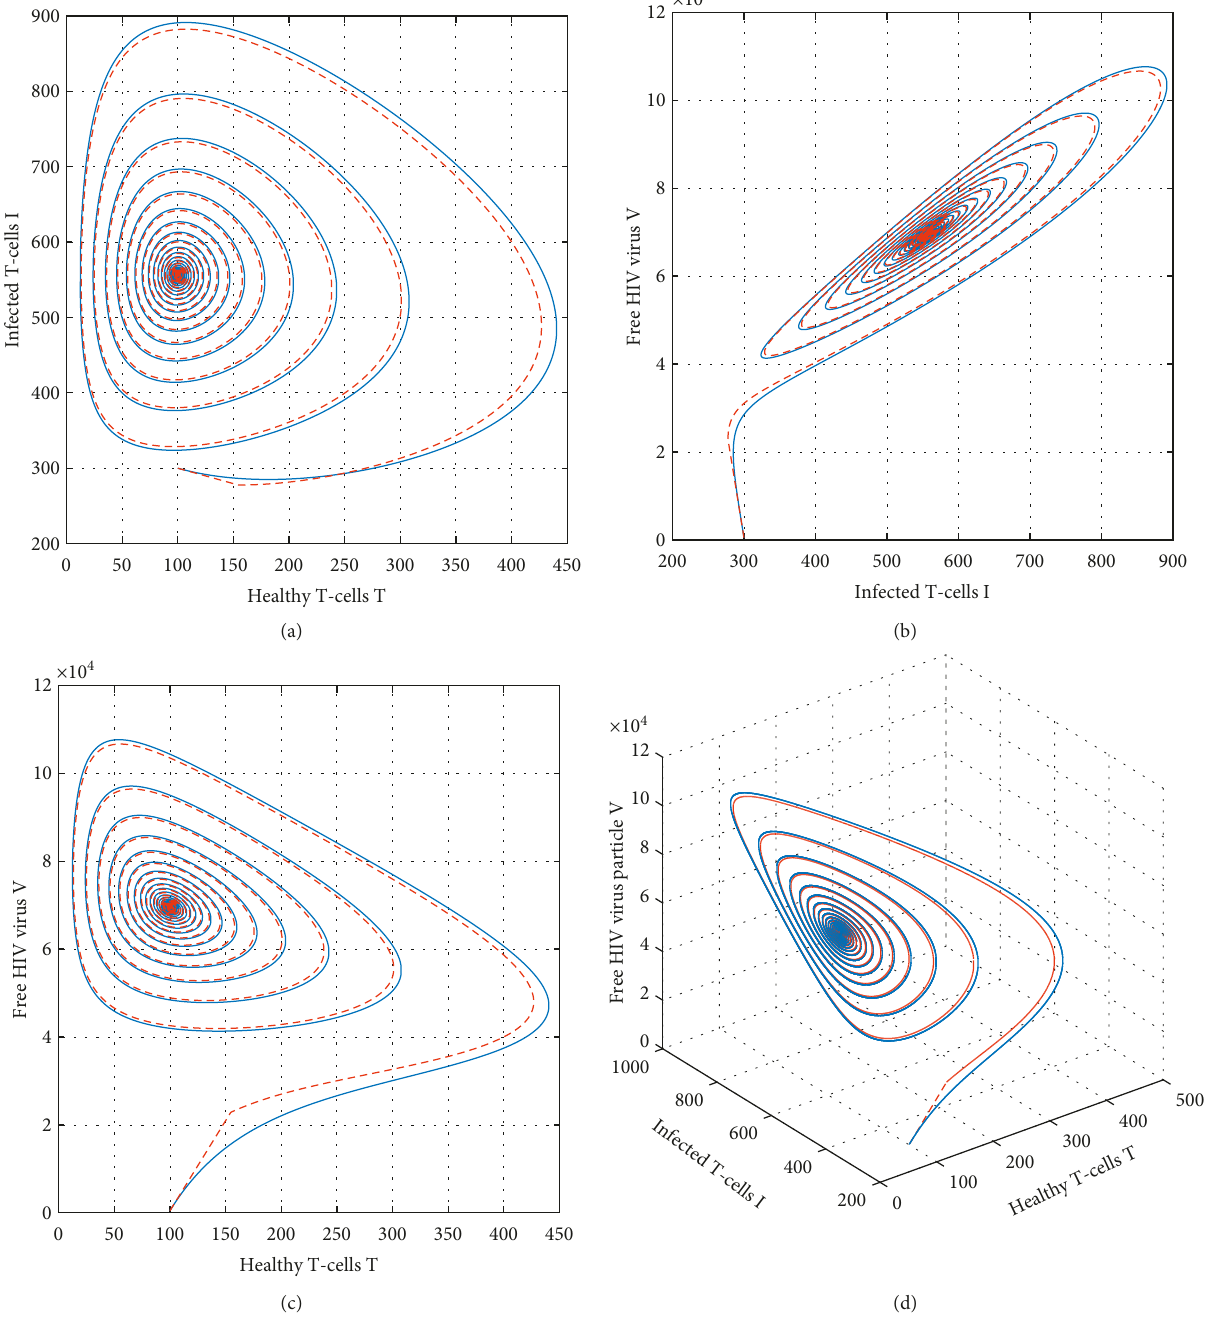
Figure 7: Graphical view analysis of the suggested fractional model (2) of HIV to represent its chaotic plot with the index of memory ϑ � 0 .